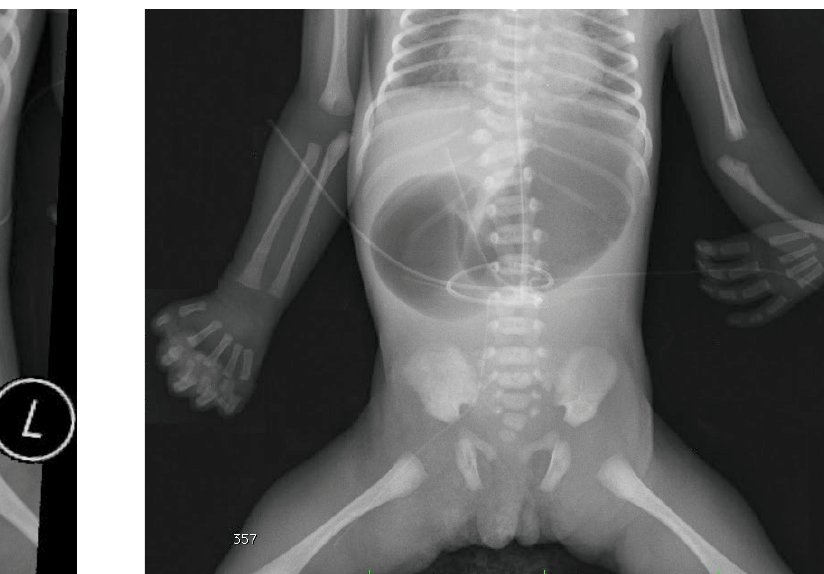
Fig. 1. Portable supine abdominal radiograph.